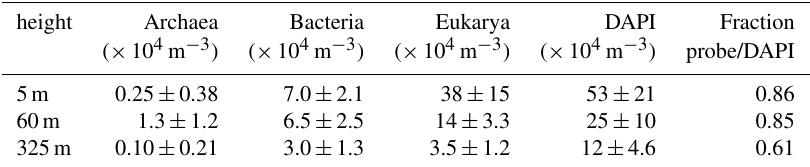
Table 2. Bioaerosol number concentrations at different heights (avg ± SD; n = 5–6, samples for ∼ 23h at each height) on the domain level (Archaea, Bacteria, and Eukarya) obtained by FISH. In addition, overall bioaerosol concentrations obtained by DAPI staining. The last column shows the fraction of cells that could be assigned to one of the domains by FISH in relation to the DAPI-derived concentration.